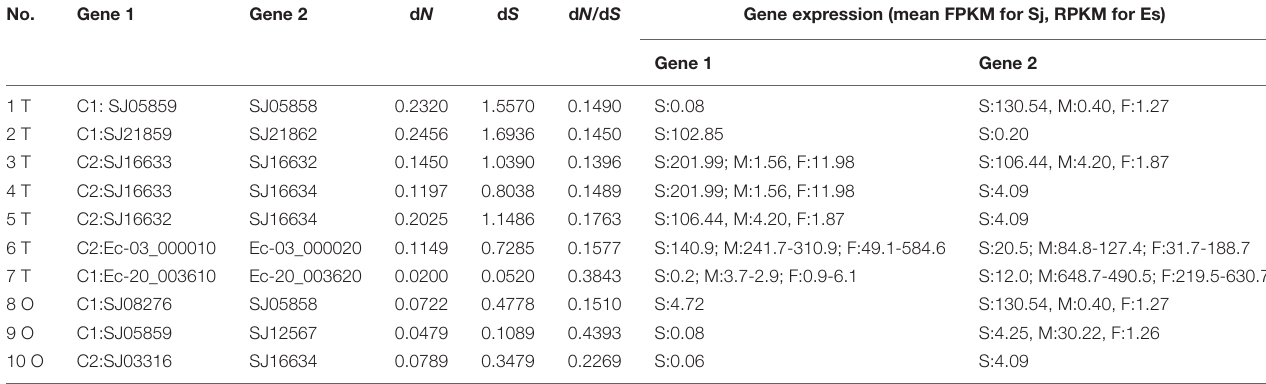
TABLE 3 | Divergence between paralogous LOX gene pairs in brown algae.